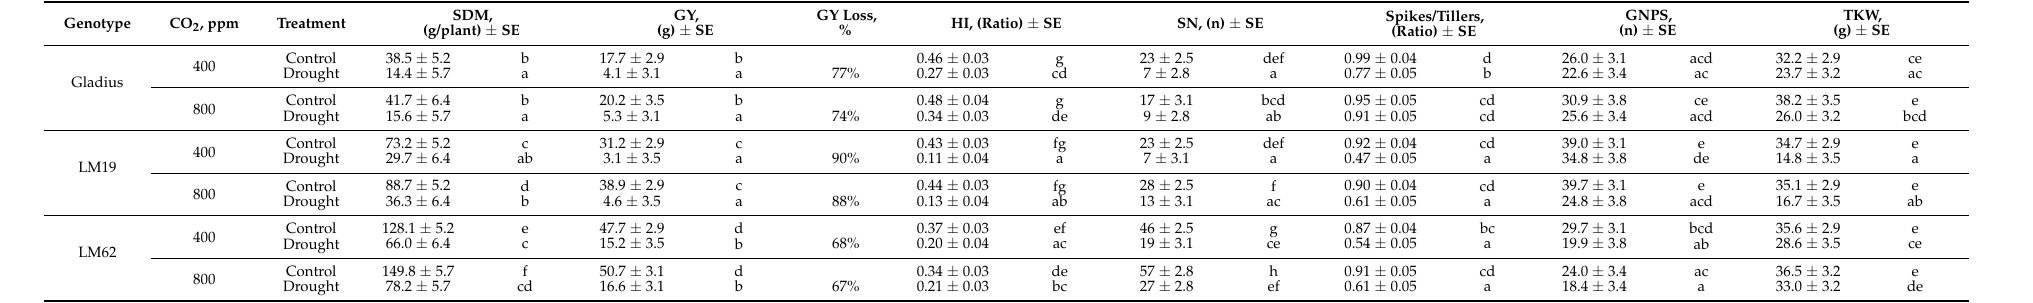
Table 3. Yield parameters: Shoot dry matter (SDM) (g), Grain yield (GY), loss in grain yield due to drought relative to control within the same CO 2 conditions (GY loss), Harvest index (HI), spike number (SN), ratio of spikes to tillers (Spikes/Tillers), grain number per spike (GNPS) and 1000 kernel weight (TKW) of the three spring wheat genotypes (Gladius, LM19 and LM62) in control and as affected by drought under ambient (400 ppm) or elevated (800 ppm) CO 2 conditions. Values that share a letter are not significantly different according to Tukey’s honestly significant test ( p < 0.05). Values are mean ± SE ( n =